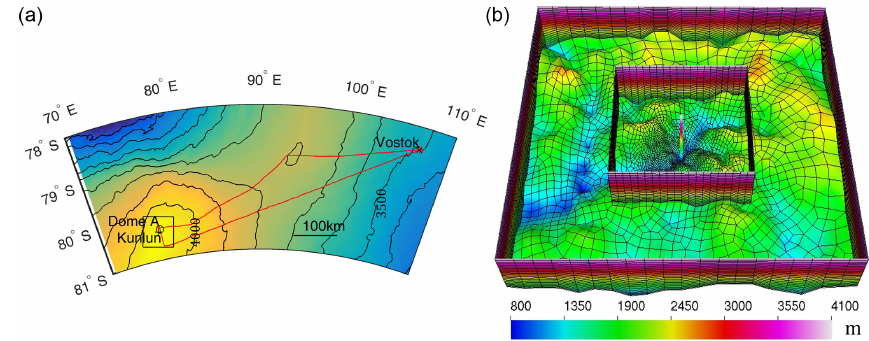
Figure 1. (a) The locations of Dome A (black circle), Kunlun (black + ) , Vostok (black x), and the 70 × 70km 2 study region (black box). The background is surface elevation with 100m contour intervals. The two radar lines that connect the Vostok drill site to Dome A are shown in red. (b) The 70 × 70km 2 finite element mesh in the vicinity of Dome A is projected on a polar stereographic map with standard parallel at 71 ◦ S and central meridian at 0 ◦ E. The background is bedrock elevation. The boundaries of the inner region and the whole region are shown, with the inner 30 × 30km 2 region centered on Kunlun station displaying a 300m resolution, and the outer region a 3km resolution. There are 21 terrain-following vertical layers with thinner layers near the base. The bar in the center denotes the drilling site at Kunlun